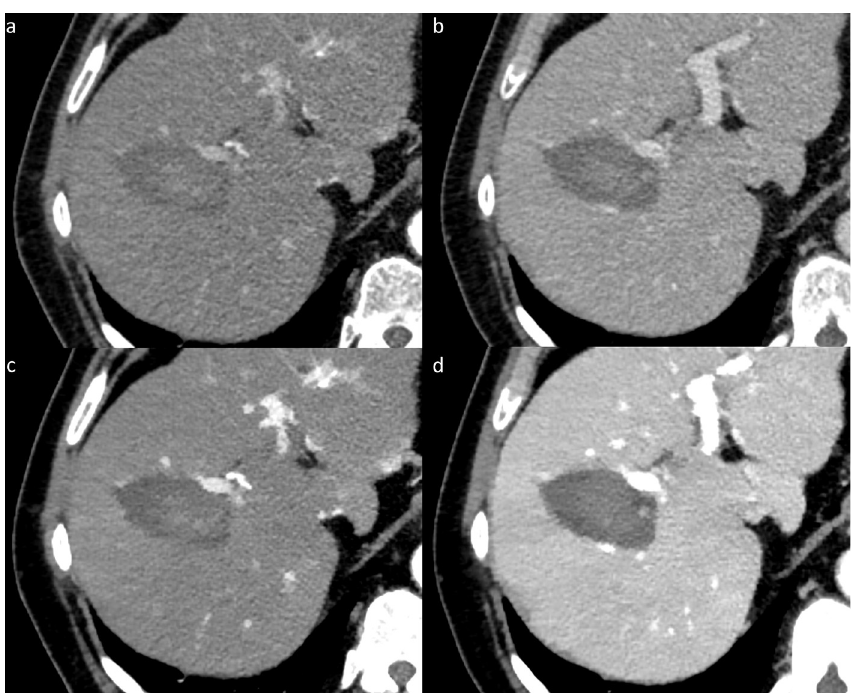
and portal-venous phase (b, d). An improved signal-to-noise ratio of the liver parenchyma, contrast-to-noise ratio of the ablation zone, a sharper ablation zone margin and a better depiction of adjacent vessels can be appreciated in the image examples of VMI 50keV (c, d) when comparing it with CI (a,